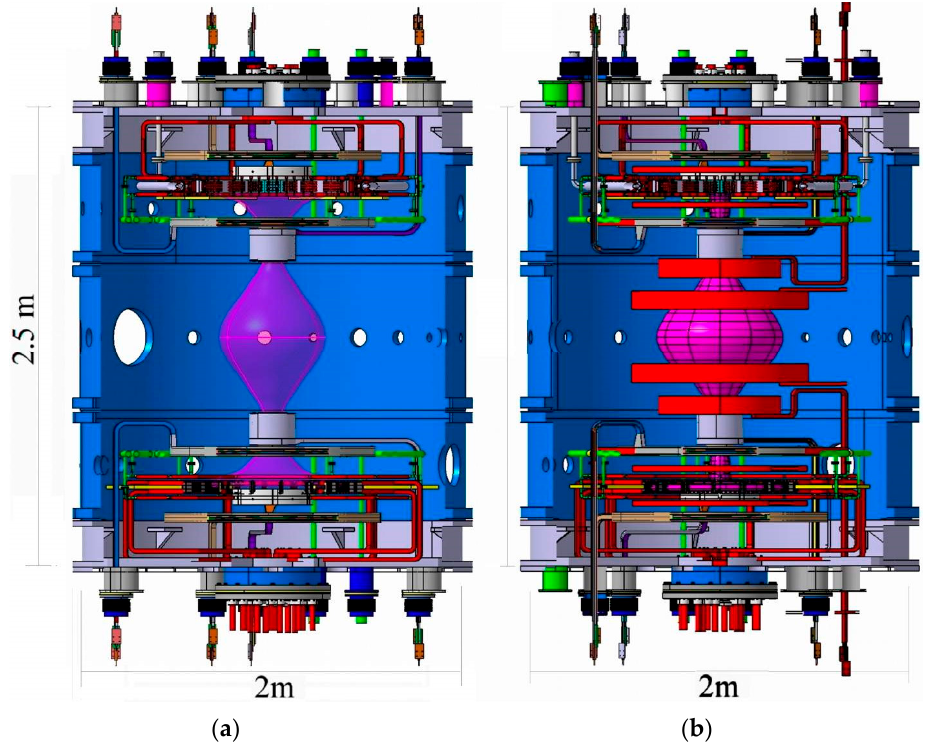
Figure 15. ( a ) Simplified set ‐ up to investigate the plasma breakdown; ( b ) Complete set ‐ up. Energies 2016 , 9 , 508